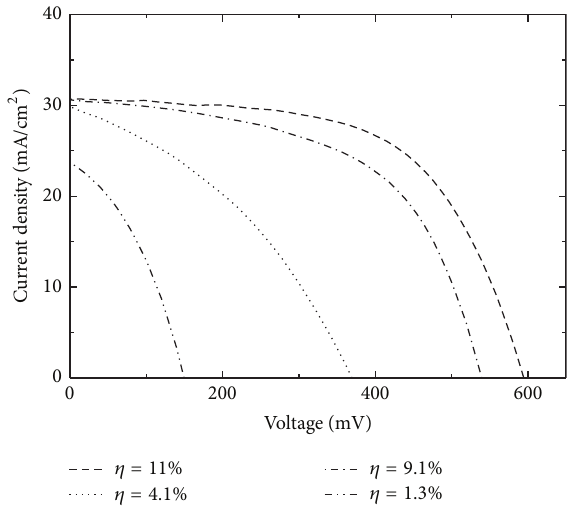
Figure 3: 𝐽 - 𝑉 curves of four CIGS samples. Cells with 11% and 4.1% conversion efficiency for the thinner and thickest ZnO:Al were generated using low thermal budget ZnO:Al deposition conditions, whilst the 9.1% and 1.3% cells also for the thinner and thickest were developed using high thermal budget